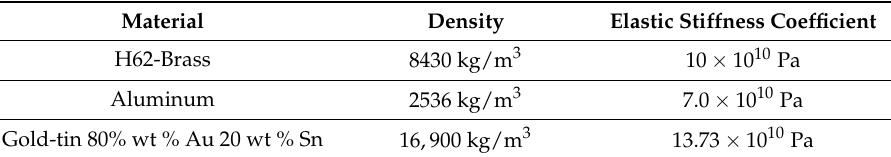
Table 2. Properties of elastic electrode.